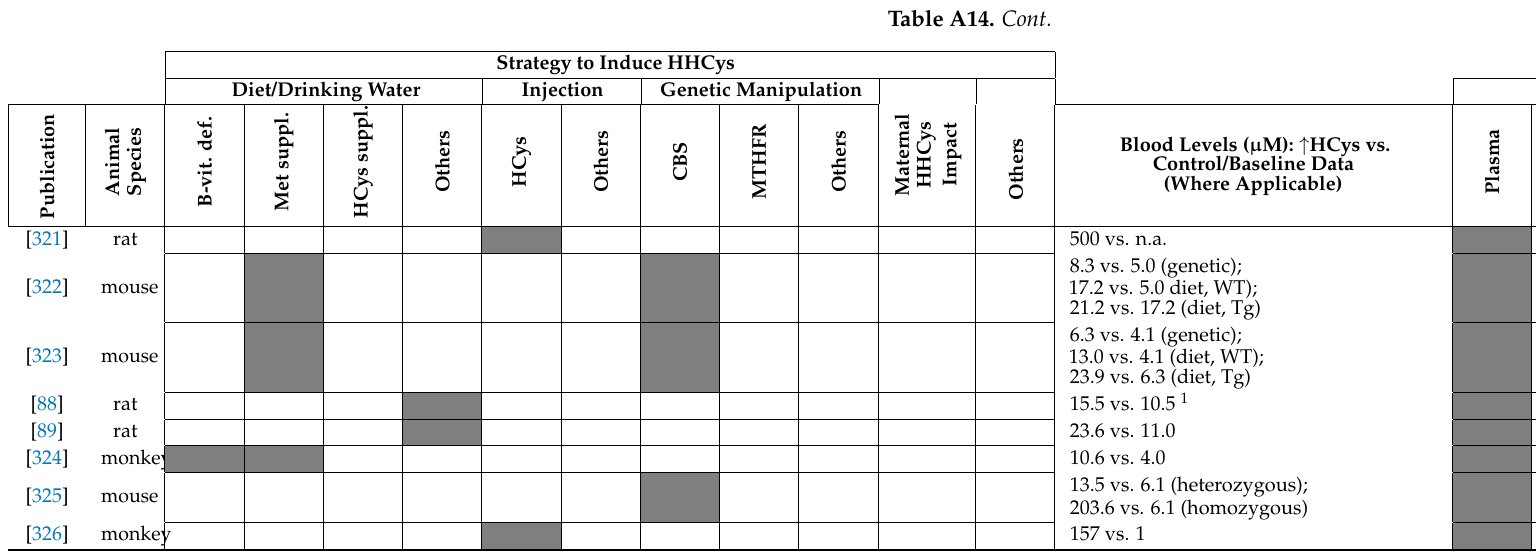
1 : Estimated from graph; levels not exactly reported in the